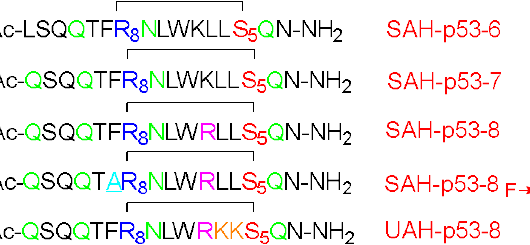
Figure 10. SAH-p53 parent peptide and ten corresponding analogs with different stapling positions. Both Asn and Gln that replaced Asp and Glu residues are shown in green; Arg that replaced Lys is shown in pink; Lys that replaced Leu is shown in orange. For S 5 refer to the legend of Figure